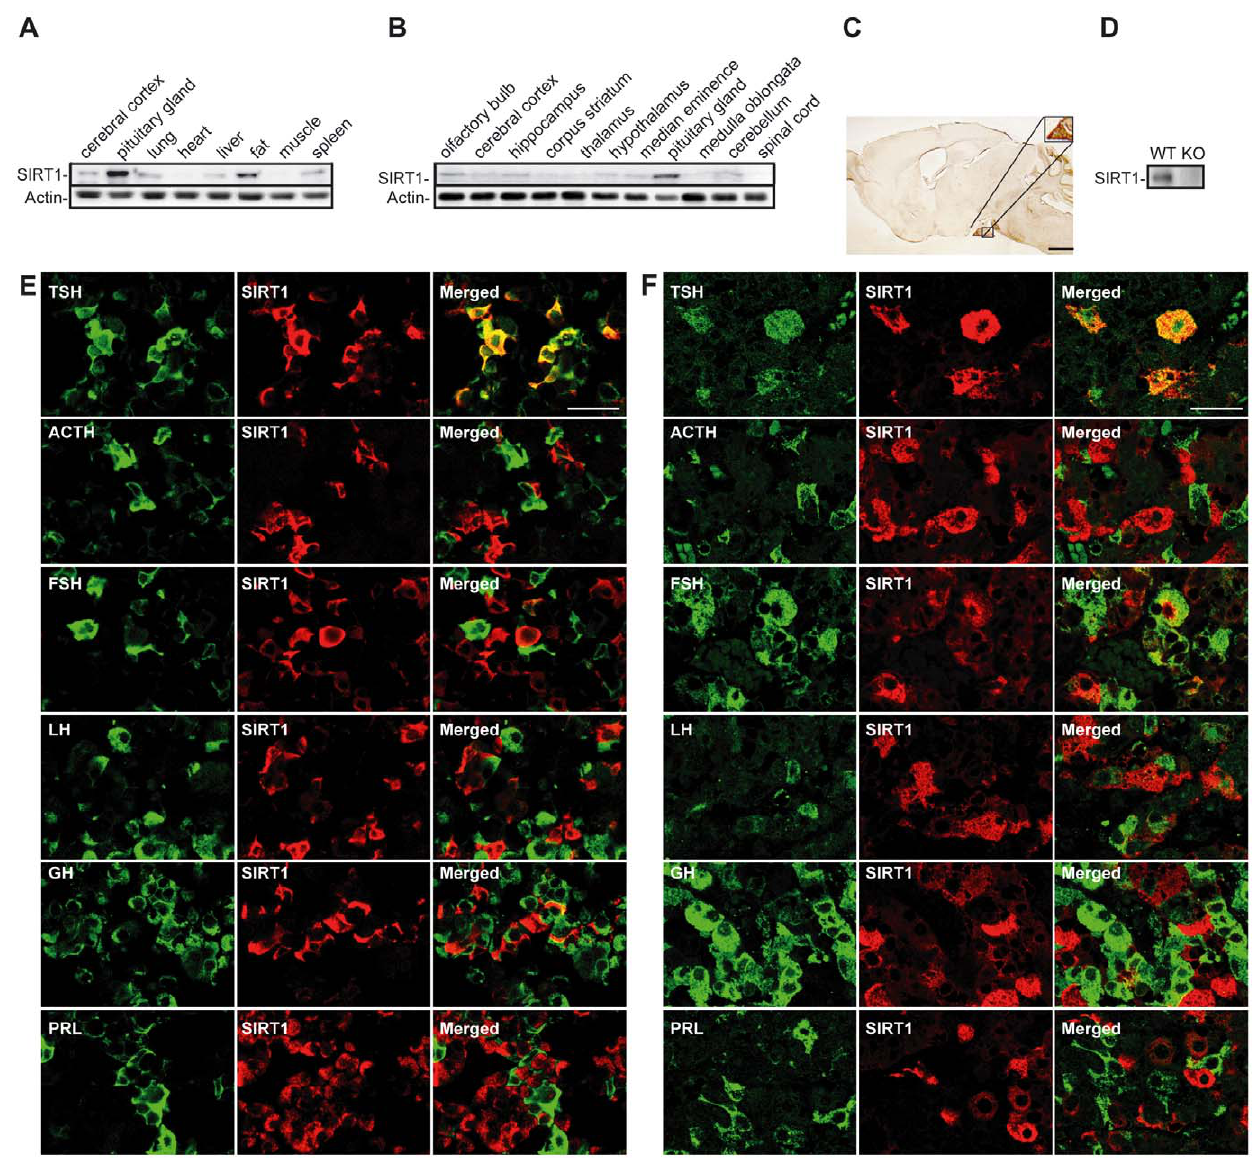
Figure 1. Effect of SIRT1 on hormone secretion. (A, B) Western blot analysis of SIRT1 in the systemic organs (A) and nerve tissues (B) of mice. (C) Immunohistochemical staining of SIRT1 in the rat brain. The upper right panel shows the anterior pituitary area at higher magnification. Scale bar, 1 cm. (D) SIRT1 immunoreactivity is absent in the pituitary gland of SIRT1 KO mouse. (E, F) Double immunostaining with SIRT1 (red) and pituitary hormones (green) in the pituitary gland of a 12-weeks old mouse (E) and a 64-years old human (F). Scale bar, 100 m